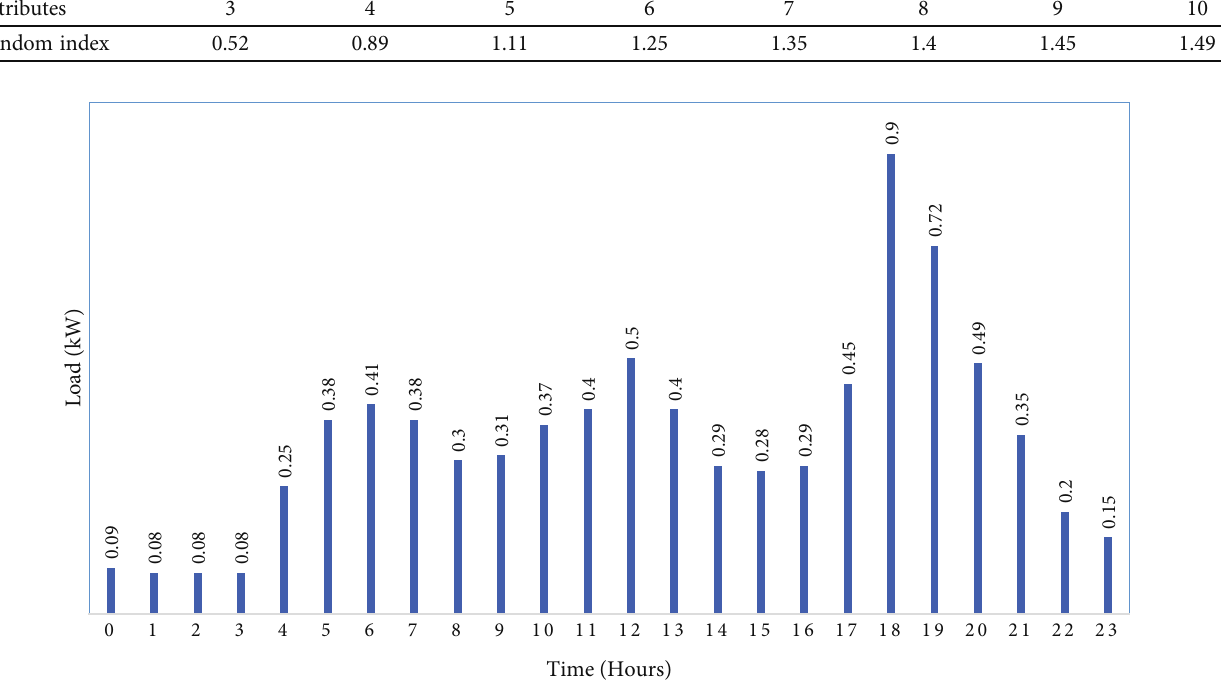
Figure 4: The hourly chart of household consumption.